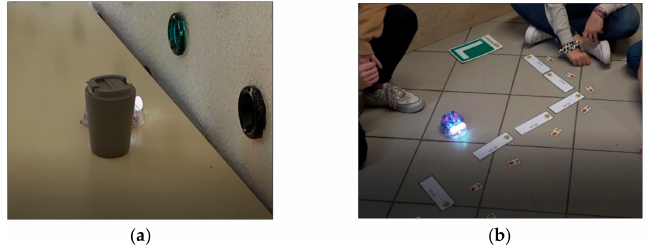
Figure 5. ( a ) Error due to excessive commands. ( b ) Error due to misunderstanding of a type of